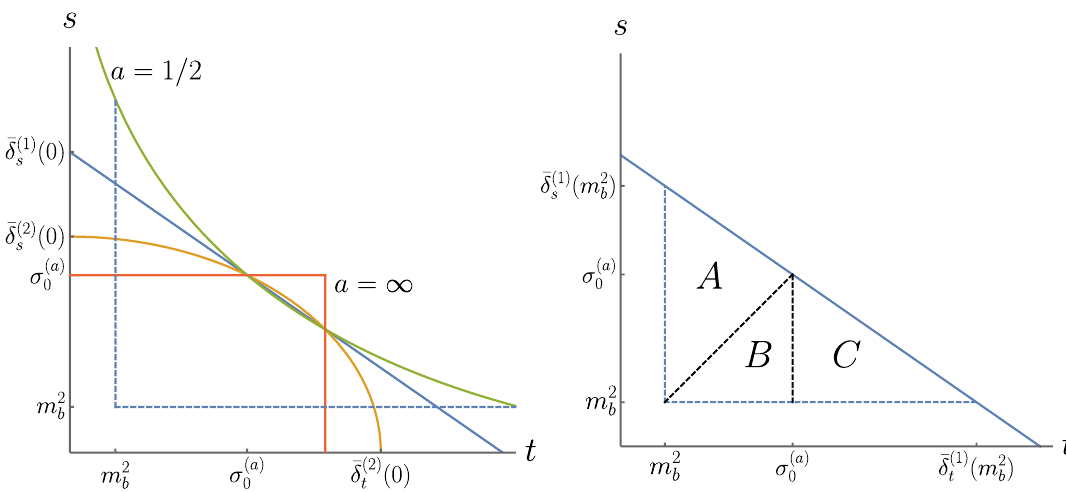
Figure 1 . An overview of the duality interval. The left hand figure demonstrates how the pa- rameterisation (3.17), keeping the quantity σ ( a ) fixed, leads to a range of possible duality windows 0 depending on the value of the parameter a . The solid green, blue, yellow, and orange curves cor- respond to the a = 1 / 2 , 1 , 2 , ∞ , cases respectively. In the limit ˜ s 0 → ˜ t 0 the curves intersect at a single point, σ ( a ) . The right hand plot provides a more detailed view of the case a = 1 , which we 0 adopt for our evaluation of the couplings. We note that the choice of duality window has little impact on the final result, cf. table 5. The dashed blue line indicates the lower boundary on the duality window, enforced by the restriction that both t and s can only take values above the cut starting at m 2 . The dashed black line indicates a technical division of the duality region necessary b for application of the principal part prescription, cf.